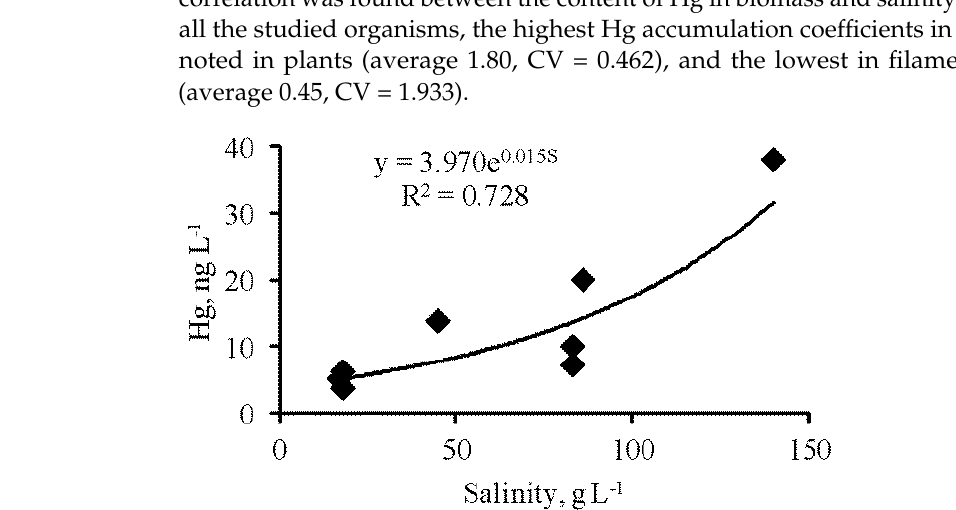
Figure 6. Dependence of Hg concentration in the biomass of filamentous green algae on salinity in Crimean saline lakes.